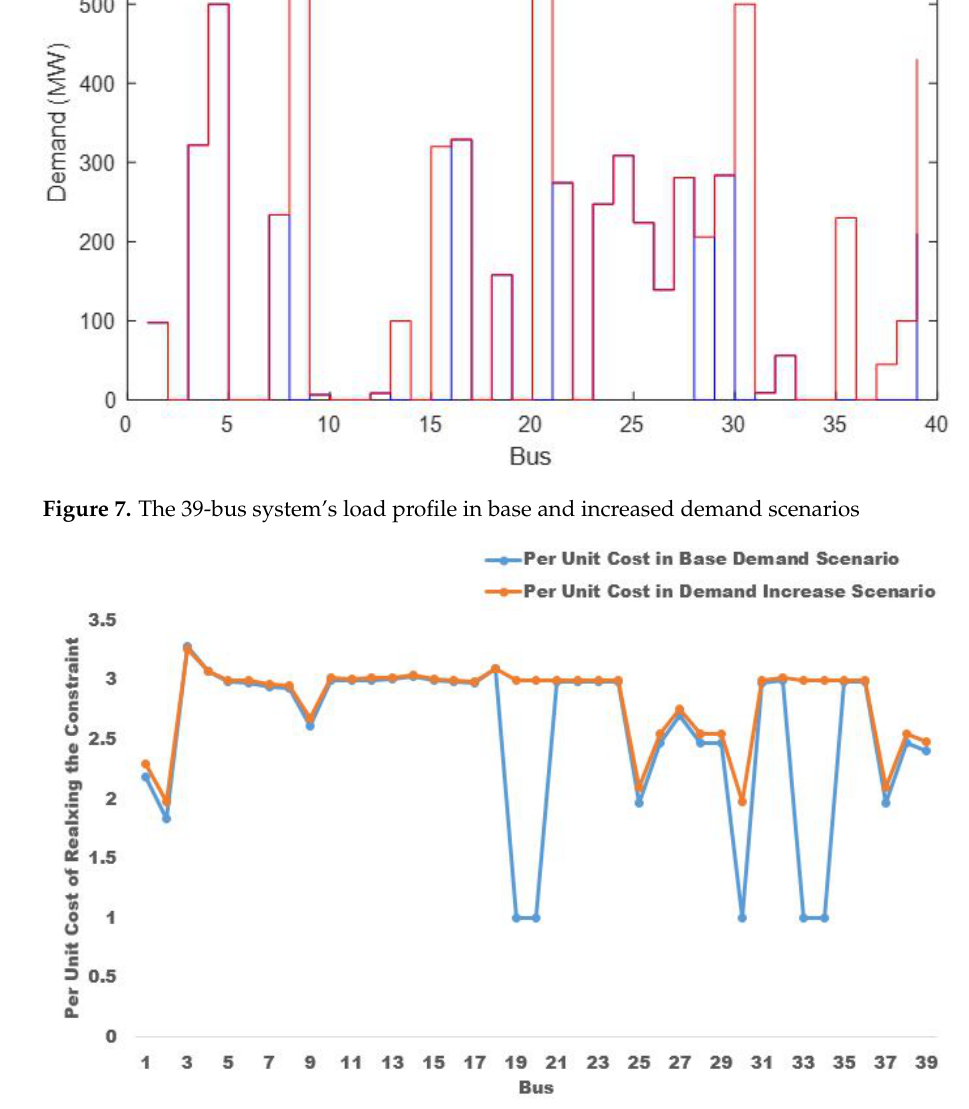
Figure 8. The per unit cost of relaxing the constraint in base and increased demand scenarios in a 39-bus